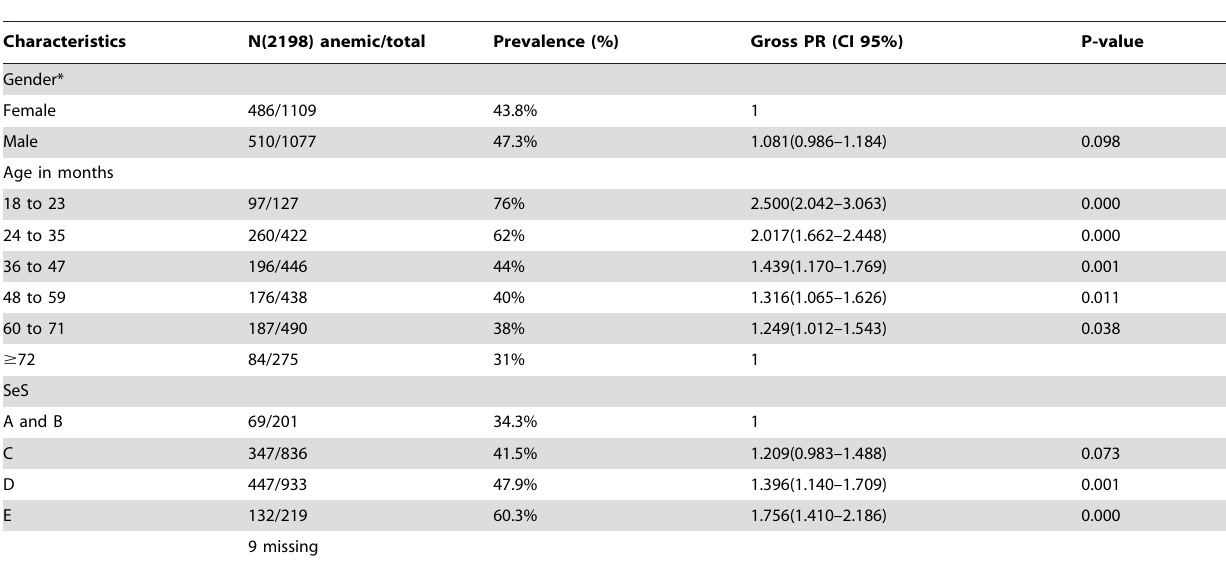
Table 1. Univariate analysis of predicting factors for anemia in children in Rio Grande do Sul, Southern Brazil, 2006–2007.